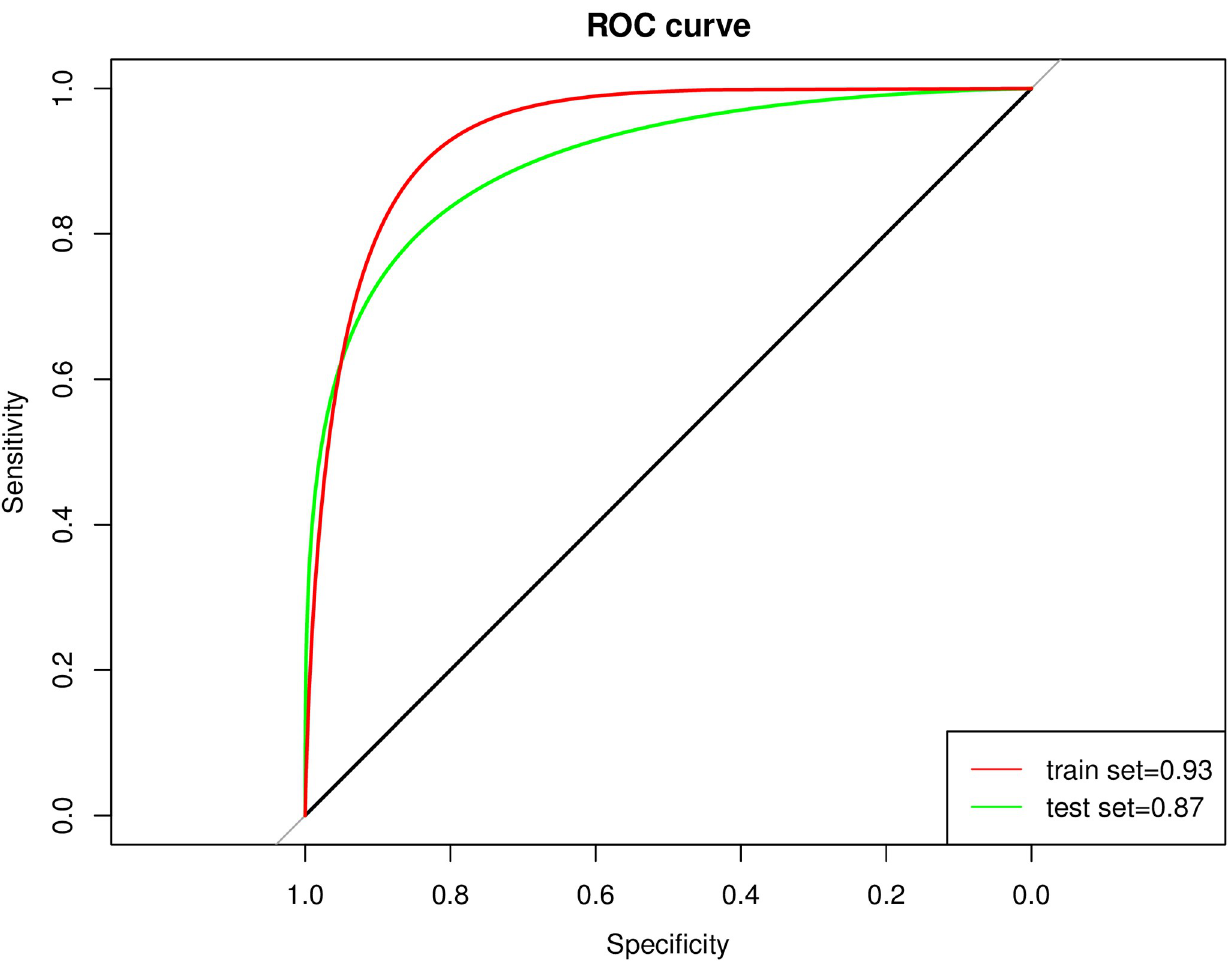
Fig 11. Roc curve. The x-axis and y-axis represent the specificity and sensitivity, respectively. The red and green curves correspond to the train and test set.